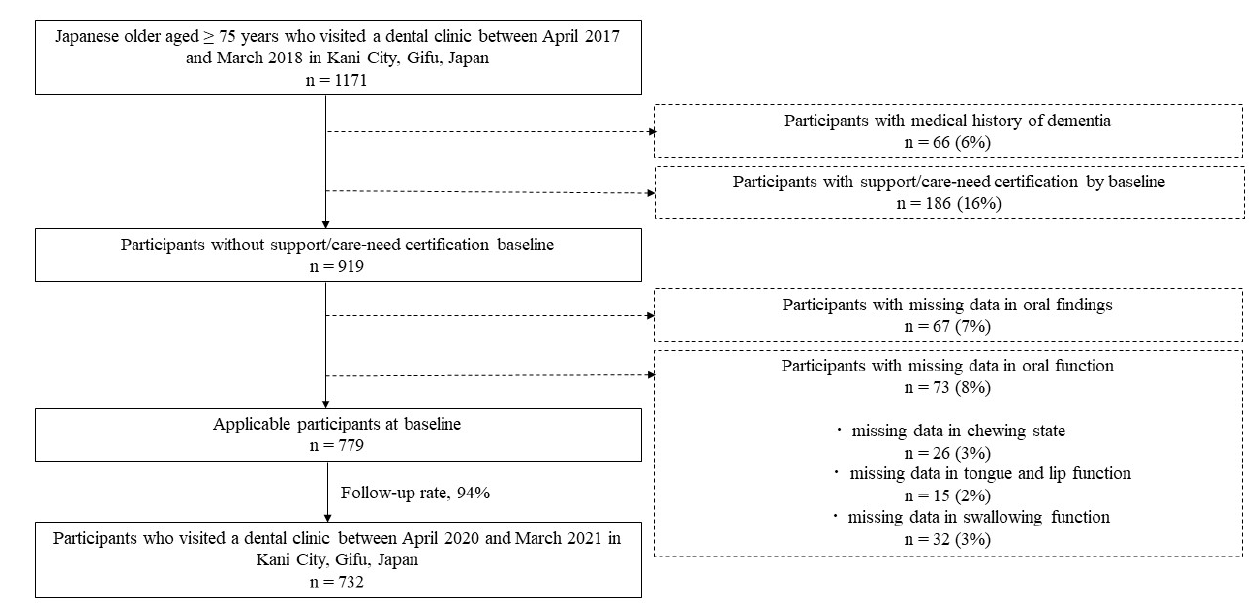
Figure 1. Flowchart of data selection criteria.